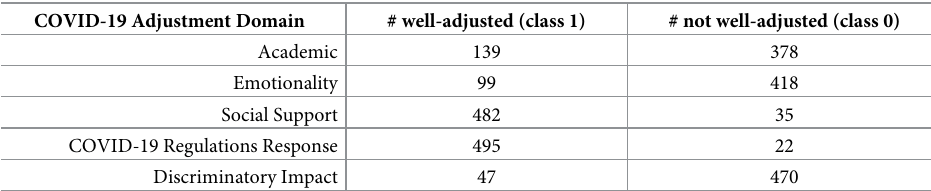
Table 1. Distribution of participants across classes in each study